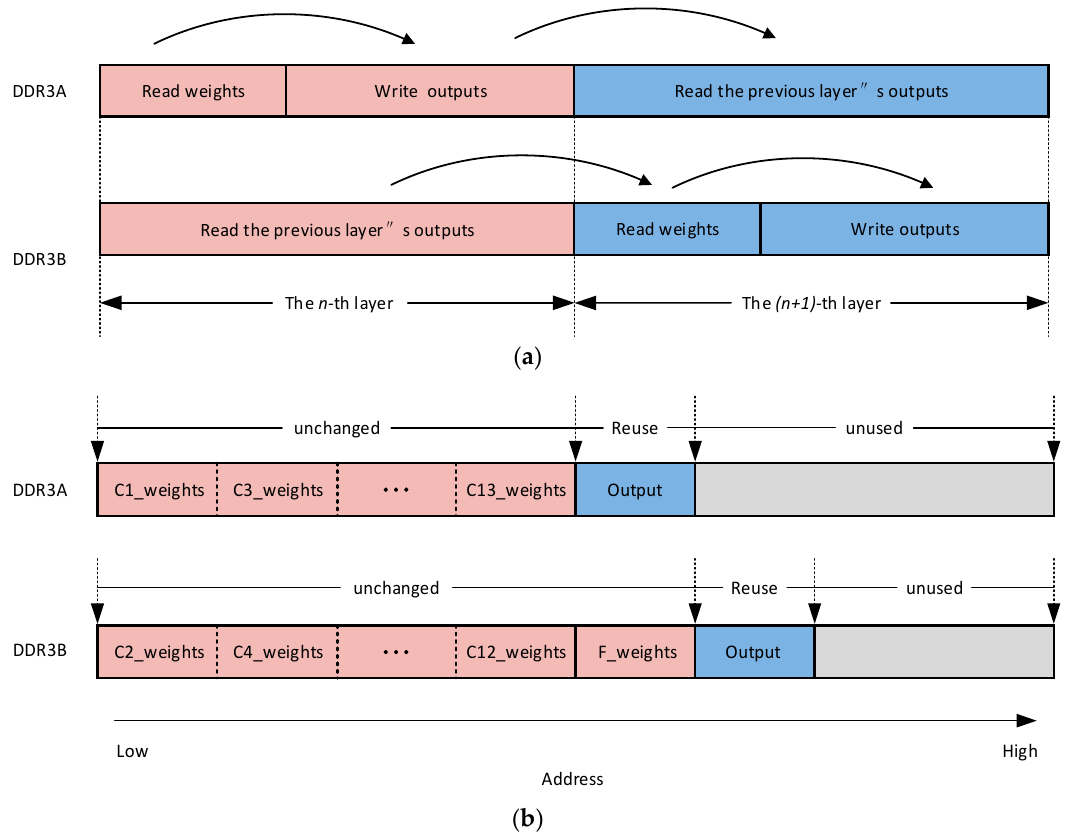
Figure 5. The arrangement of the independent dual-channel Double Data Rate Synchronous Dynamic Random-Access Memory (DDR). ( a ) The working state of the dual-channel DDR; ( b ) The address arrangement of the dual-channel DDR. Ci_weights ( i = 1, 2, ··· , 13 ) and F_weights refer to the weights of the i- th convolutional layer and the full connection (FC) layers, respectively.